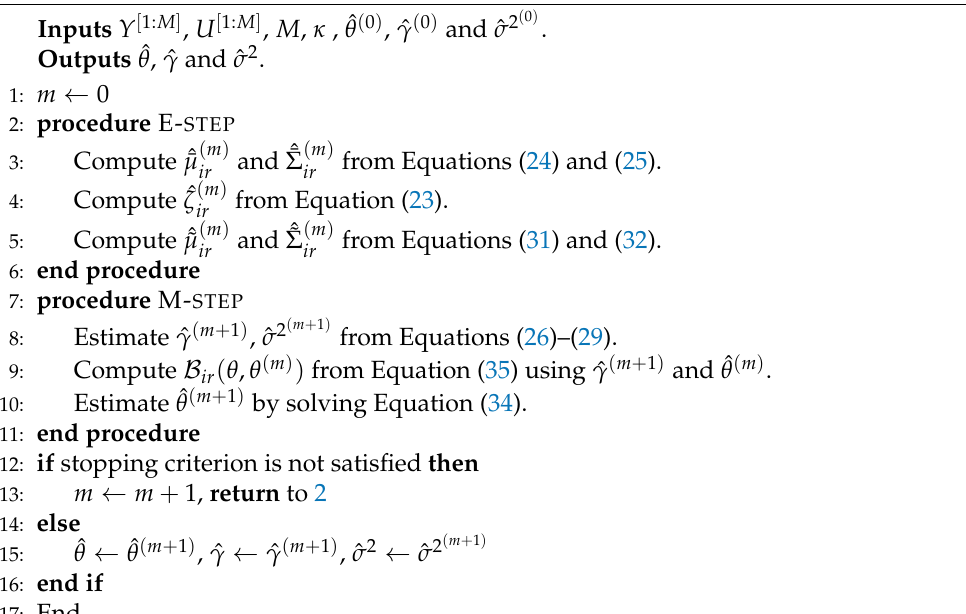
Algorithm 1 (EM algorithm with